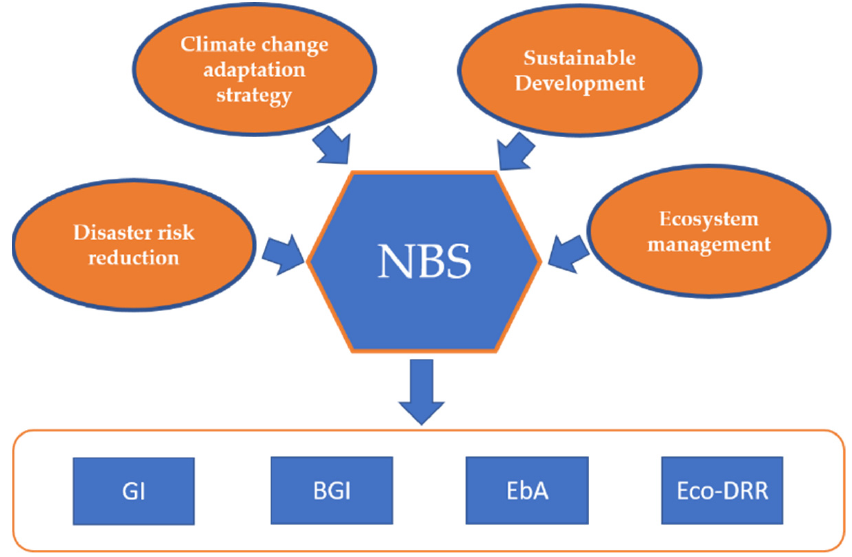
Figure 8. Nature ‐ based solutions as an approach towards risk reduction, sustainable development, and conservation/restoration of water ‐ related ecosystems within a climate ‐ change ‐ adaptation strat ‐ egy.